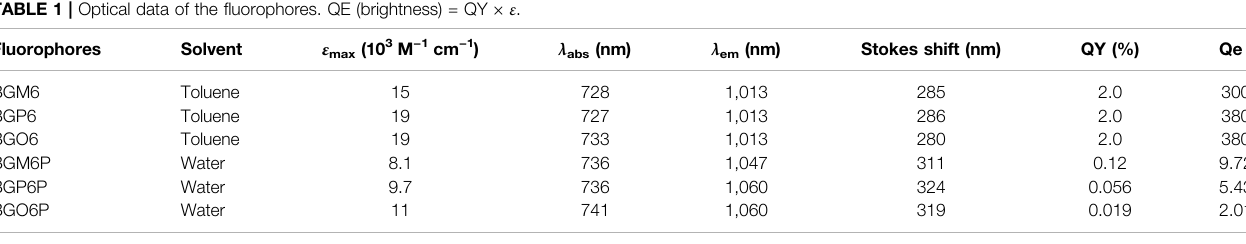
TABLE2| Sizedistributionof fl uorophoresinwater(0.05 mg/ml)bydynamiclightscattering(DLS)methodandkineticbindingassayof fl uorophorestoalbuminmeasuredby bio-layer interferometry.